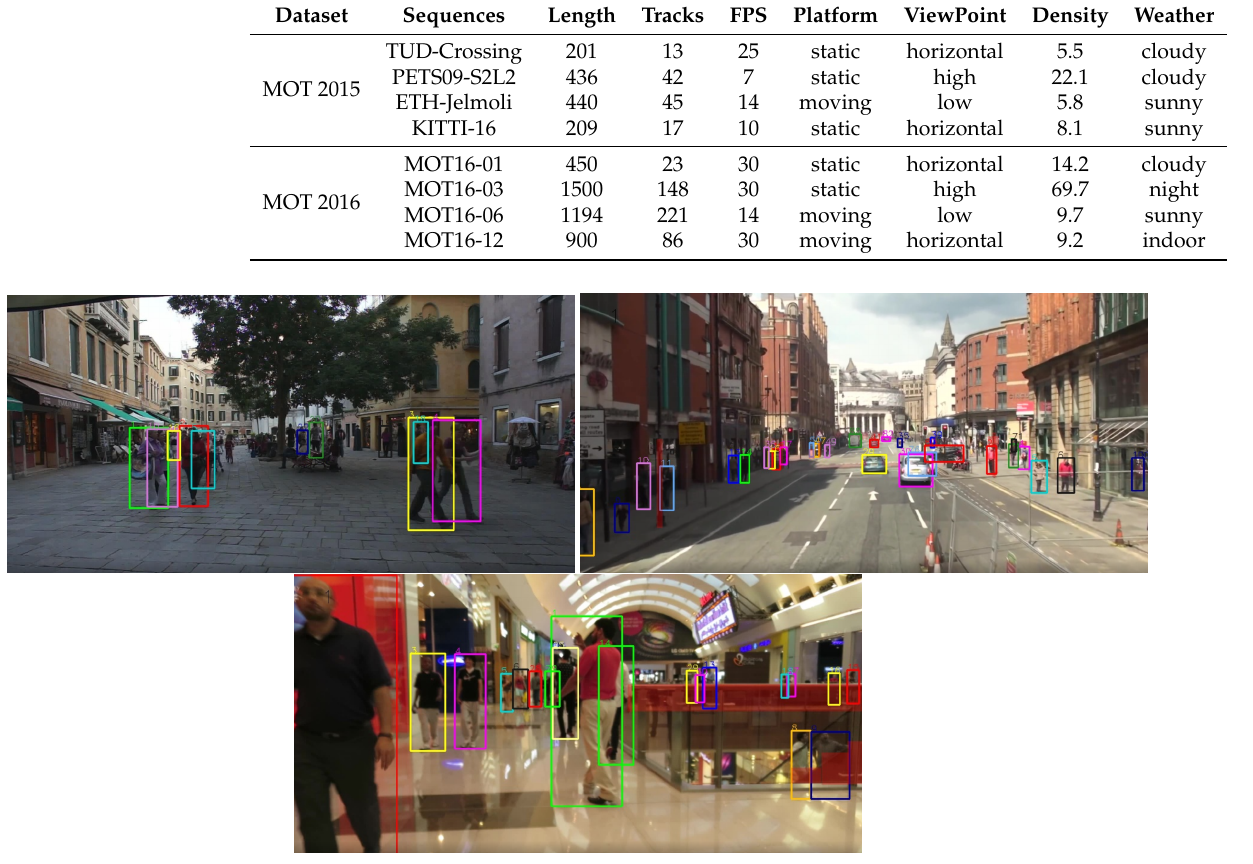
Figure 10. Samples from MOT 15-17 ground truth dataset. Samples of MOT15 ( top image ), MOT16 ( middle image ), and MOT17 ( bottom image